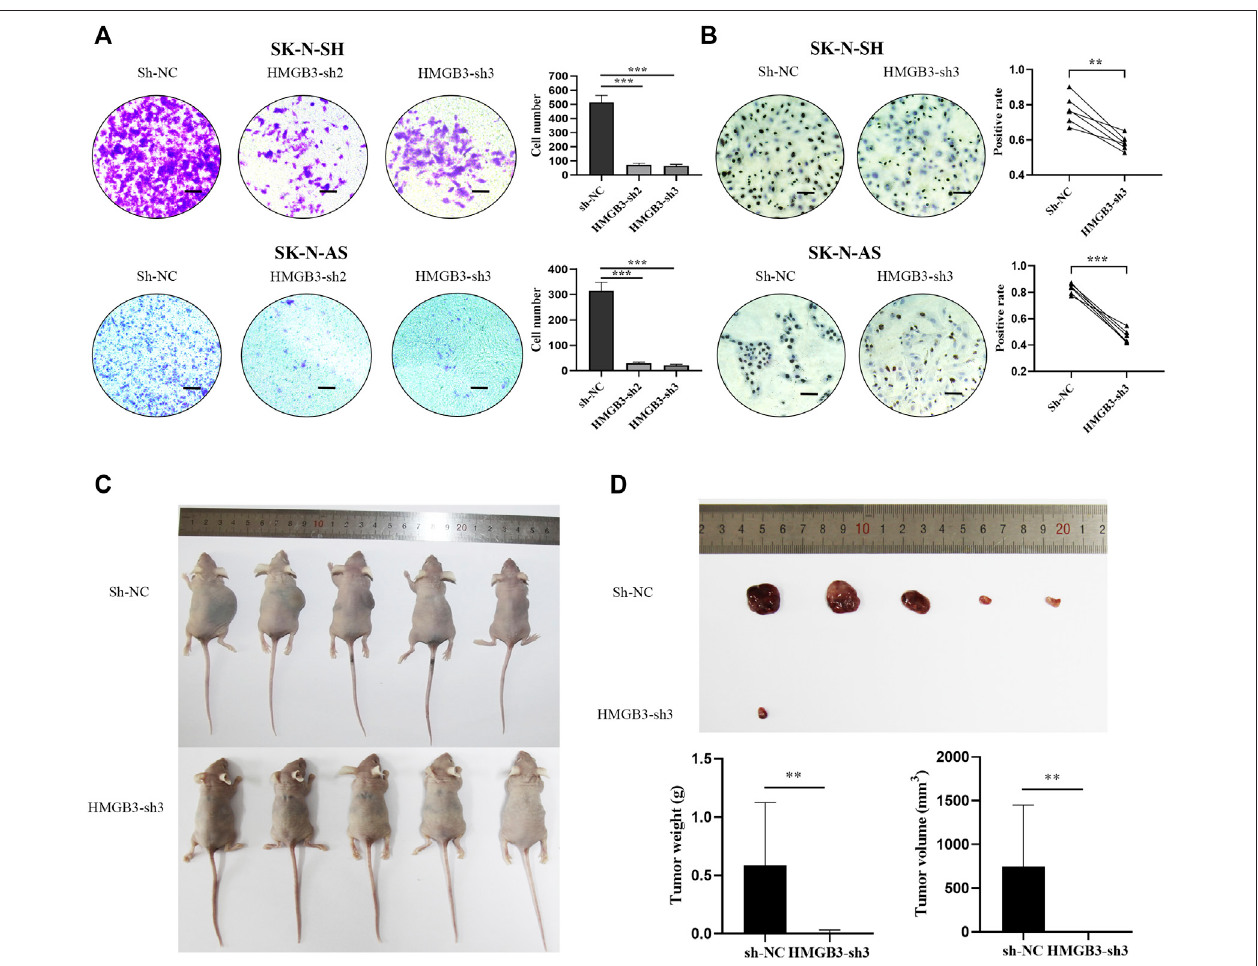
FIGURE 3 | Knockdown of HMGB3 inhibited cell invasion and growth in NB cells in vitro and in vivo . (A) Transwell assay for SK-N-SH and SK-N-AS cells with/ without HMGB3 knockdown. (B) Immunocytochemistry analysis of KI-67 protein was performed in SK-N-SH and SK-N-AS cells. (C) Paired xenograft tumors and their relative injected subcutaneously with sh-NC or sh-HMGB3 SK-N-SH cells. (D) Tumor weight. Scale bars, 50 μ m * p < 0.05, ** p < 0.01, and *** p < 0.001.